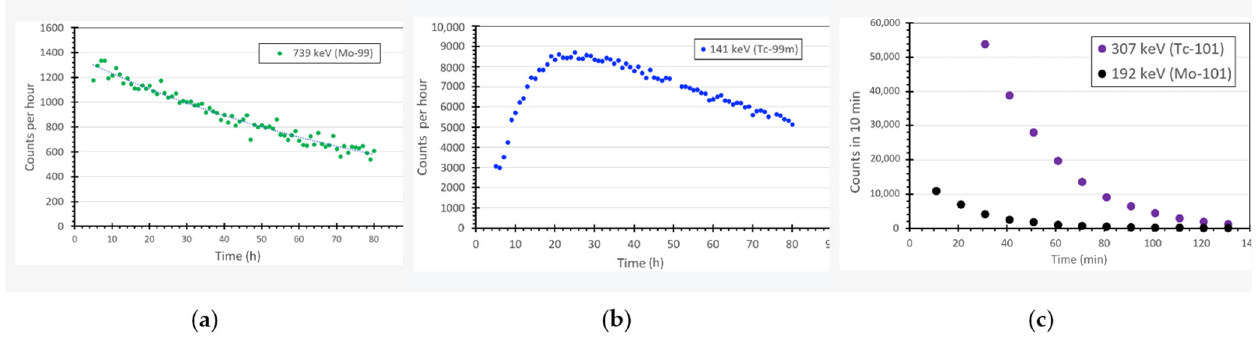
Figure 3. Gamma-ray emission from an irradiated molybdenum-containing sample for which the extraction process was not performed. ( a ) Counts in the 739 keV line from 99 Mo as a function of time, and ( b ) counts in the 141 keV line of 99m Tc as a function of time, ( c ) counts in the 307 keV line for 101 Tc (purple) and 192 keV for 101 Mo (black).